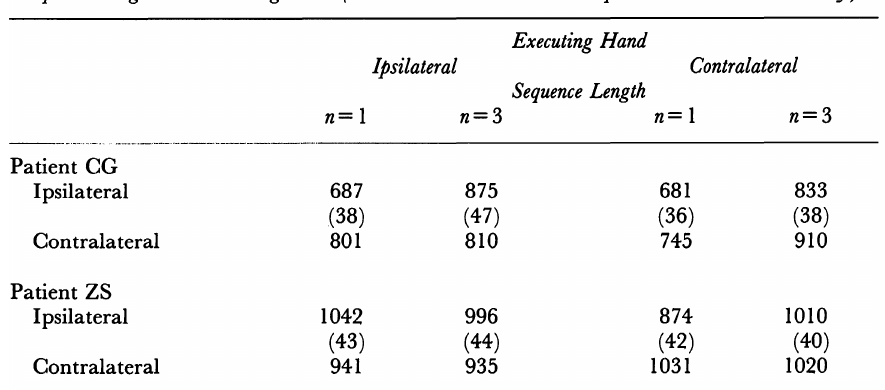
rif patients CG and ZS on valid and invalid trials as a function of TABLE I. Response onset times Sequence Length and Executing Hand (Standard Errors are shown in parentheses-valid trials onry).